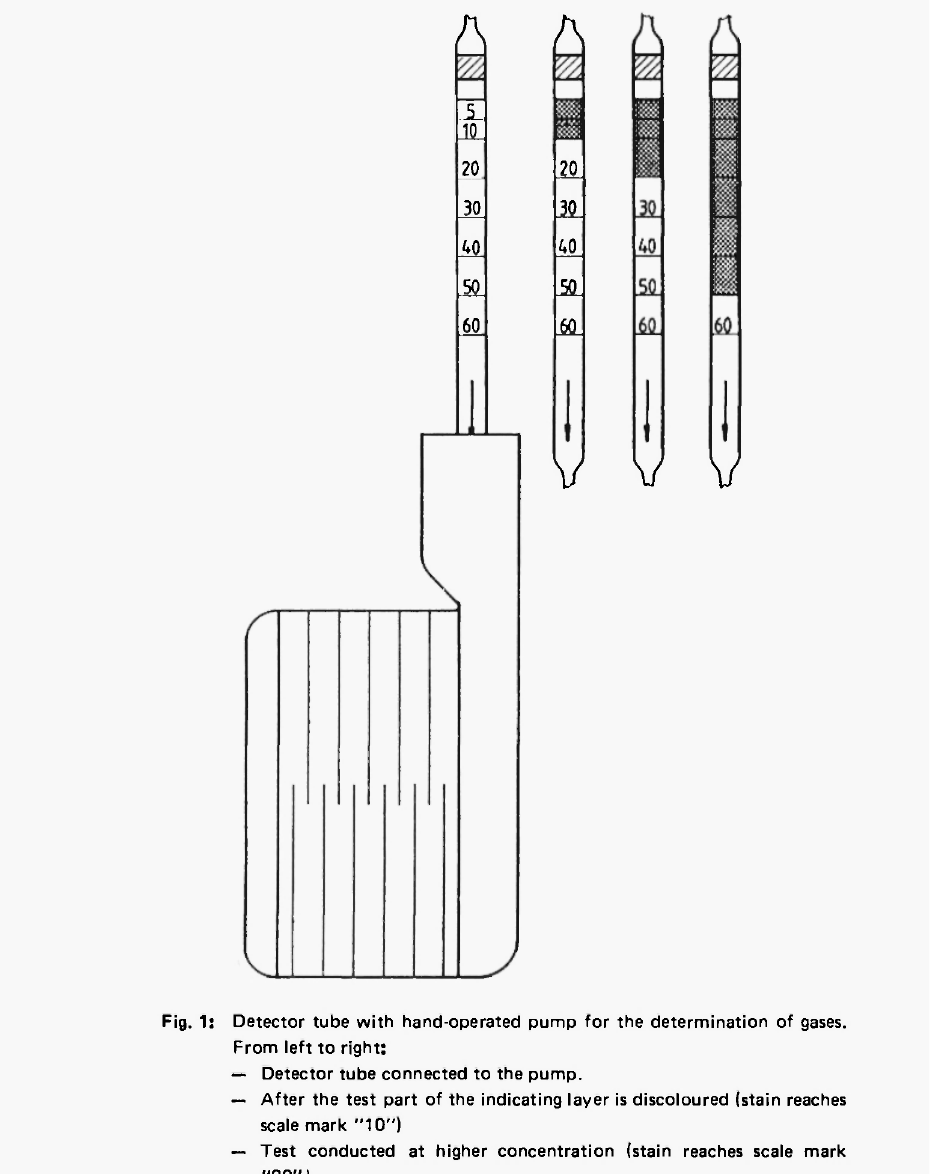
Fig. 1: Detector tube with hand-operated pump for the determination of gases. From left to right: — Detector tube connected to the